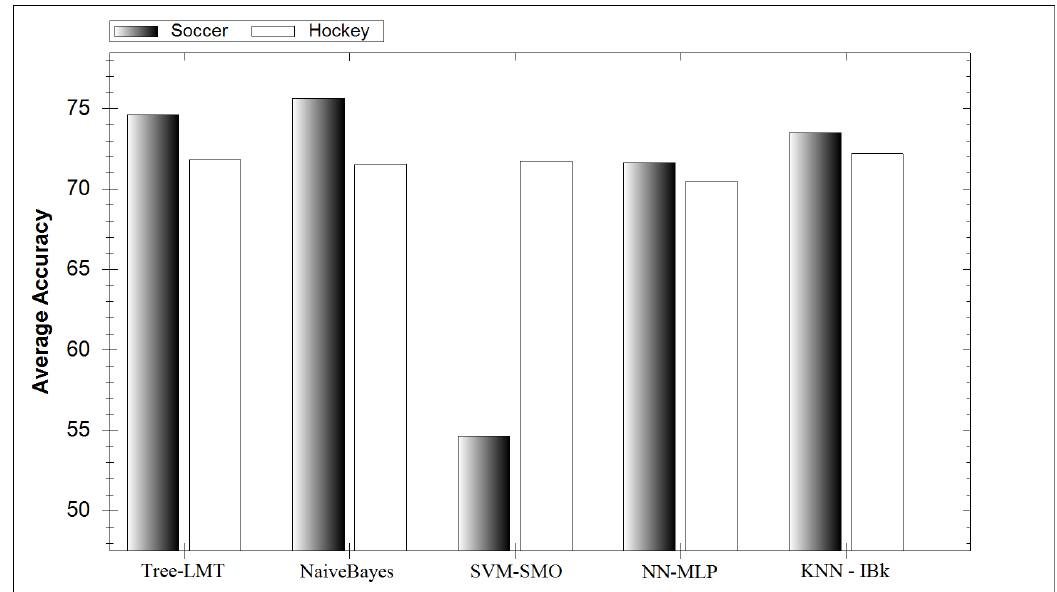
Figure 4. Average classifier family accuracy for experiment